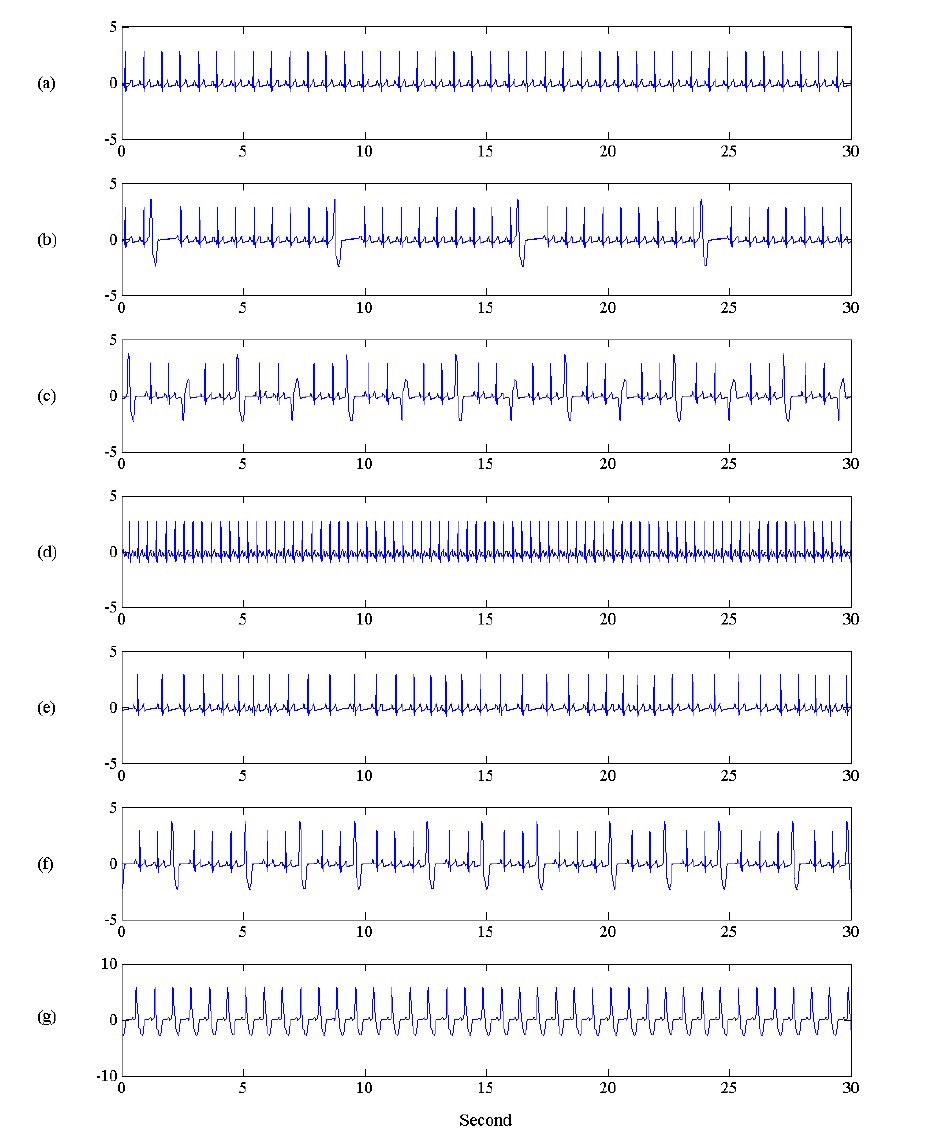
Figure 2. Illustration of normal and arrhythmia ECG signals used in this study. Signal durations are 30 s. From top to bottom: (a) normal ECG, (b) premature arrhythmia with PVC1, denoted as P1, (c) premature arrhythmia with multifocal PVC, denoted as P2, (d) superavent arrhythmia with atrial tach, denoted as S1, (e) superavent arrhythmia with sinus arrhythmia, denoted as S2, (f) ventricular arrhythmia with 24 PVCs per min, denoted